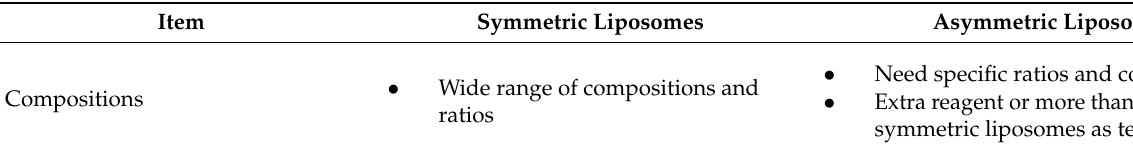
Table 2. Comparison between symmetric and asymmetric